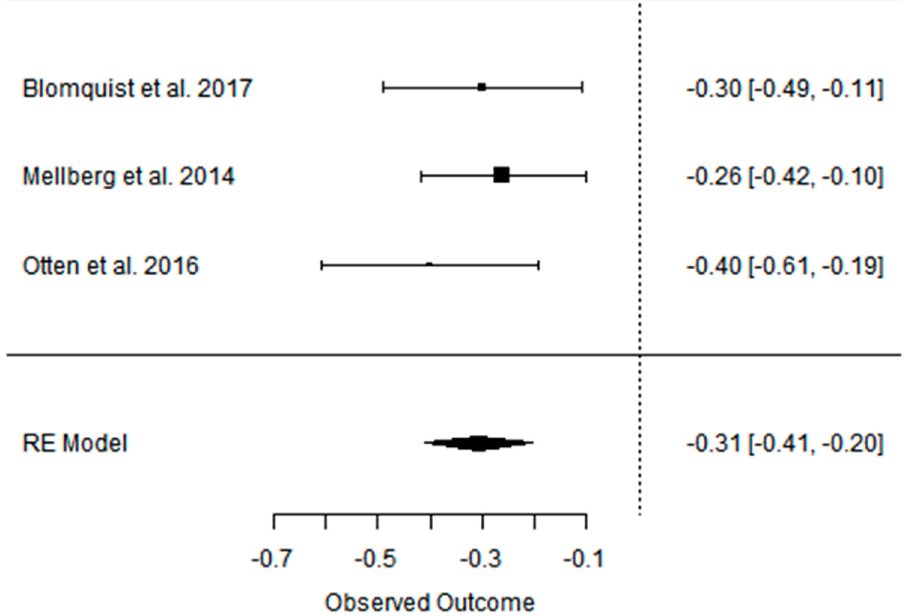
Figure A32. Forest plot of the effect of a PD on LDL-C in the long term (weighted mean difference).